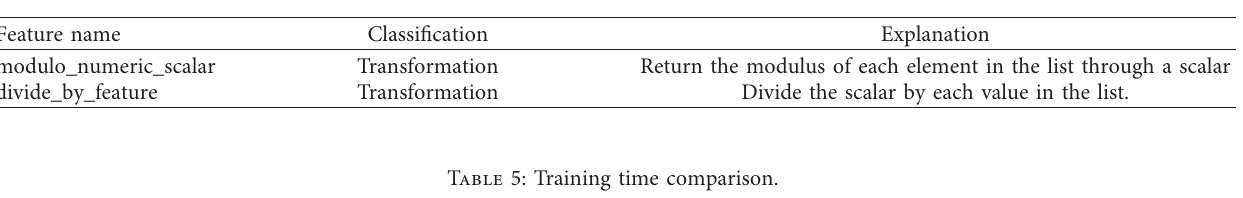
Table 4: Generated features.